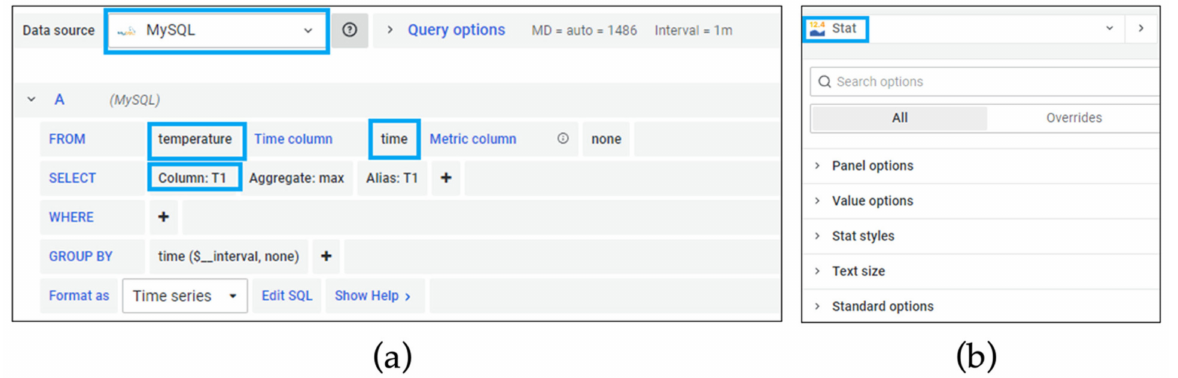
Figure 9. Grafana dashboard options ( a ) Selecting table and data ( b ) Data presentation options.